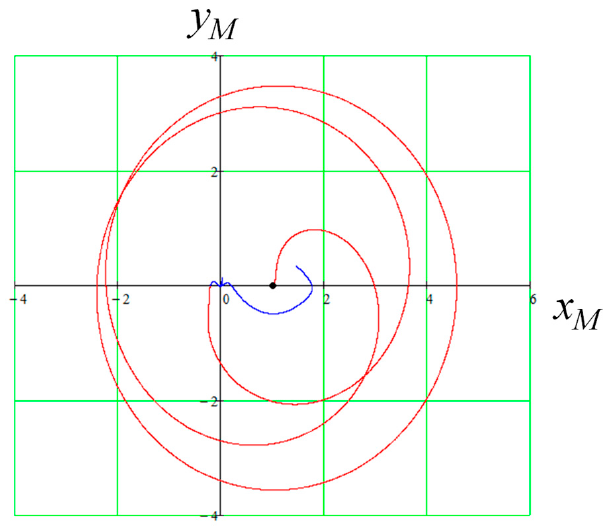
Figure 22. Complete SC trajectory starting from the moment of stratum from the Earth (black circle); built in a rotating selenocentric coordinate system, the main direction of which coincides with the direction of the Moon-Earth axis.